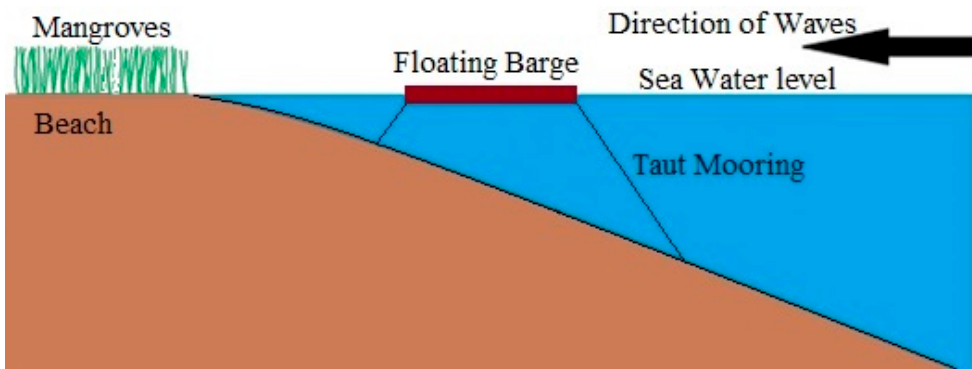
Figure 6. Schematic diagram of mangroves grown on the beach after the barge has been moored to the location.